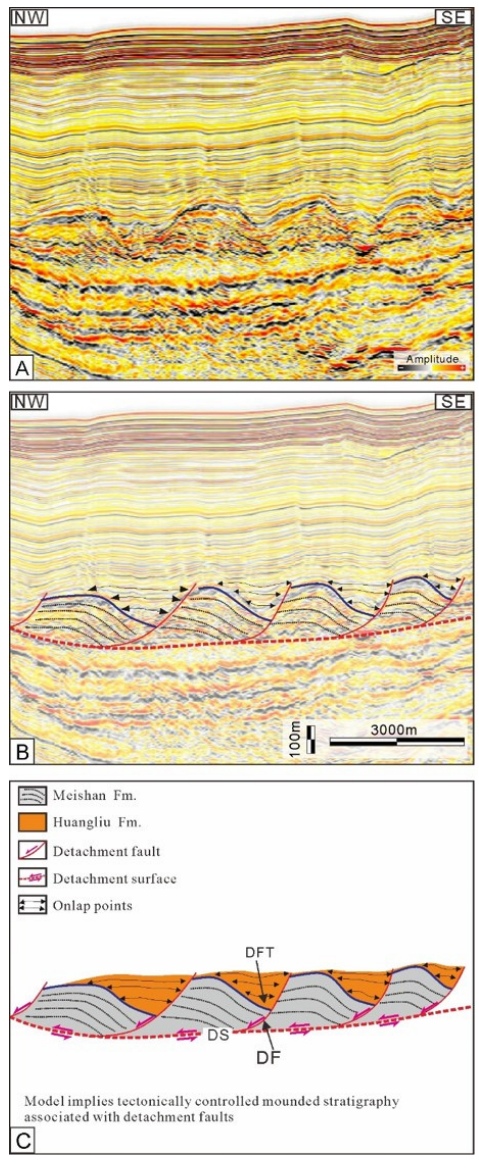
Figure 11. ( A ) Uninterpreted seismic profiles, ( B ) interpretations, and ( C ) their geological models showing the formation of the mounded stratigraphy (for locations, see Figure 1). The tilted fault blocks rest on the fault plane of detachment faults, with their tops constituting the seemingly mounded topography. DS = detachment surface; DF = detachment fault; DFT = downfaulted trough; TWT = two-way traveltime.